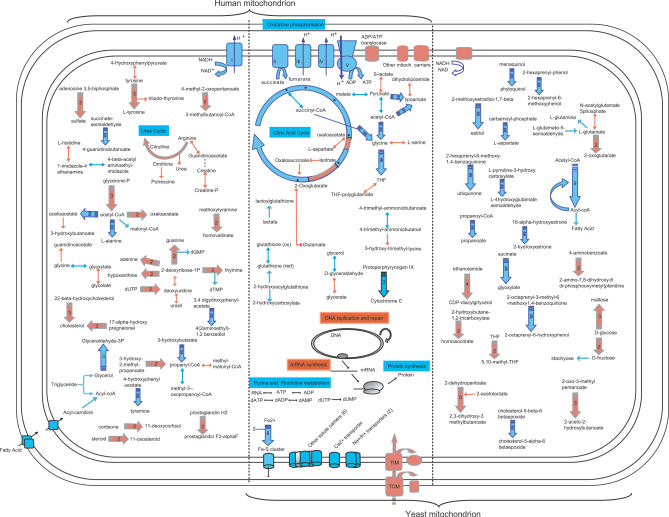
Reconstructed Human and Yeast Mitochondrial Metabolic PathwaysHuman (left) and yeast (right) metabolic pathways were deduced from the function of the proteins compiled in the MitoProteome Dataset [25] and present in the yeast proteomics set [24], respectively. In order to facilitate the comparison of both metabolic pathways, pathways shared by the two species are depicted in the middle region of the figure, pathways at the extremes of the dashed lines are exclusive for human (left) or yeast (right) mitochondria. Color codes indicate whether the pathway was likely present in the proto-mitochondrion (blue) or has a different origin (red). Only those pathways with two or more consecutive steps are depicted. Symbols are as in Figure 2. All proteins are nuclear-encoded except for nad1–6 subunits of Complex I in human; the atp9 subunit of Complex V in yeast; and the Cob subunit in Complex III, cox1–3 subunits of Complex IV, and the atp6 and atp8 subunits from Complex V in both species.